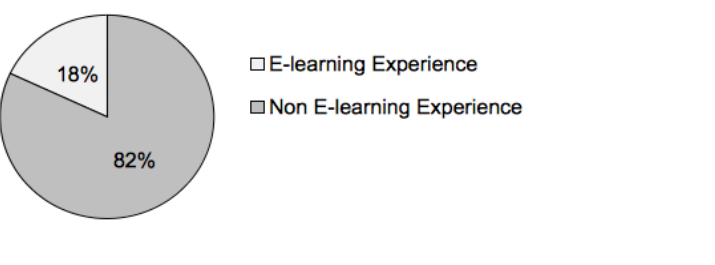
Figure 4. E-learning experience versus non e-learning experience students who use